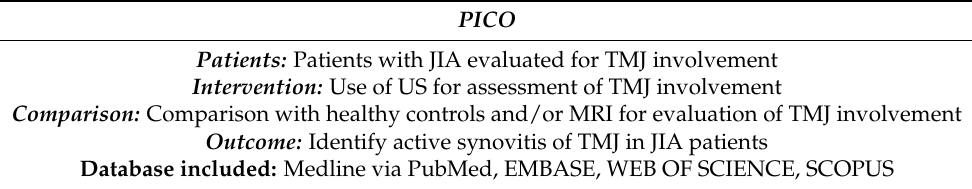
Table 1. The PICO table (population, intervention, comparison, and outcome). PICO Patients: Patients with JIA evaluated for TMJ involvement Intervention: Use of US for assessment of TMJ involvement Comparison: Comparison with healthy controls and/or MRI for evaluation of TMJ involvement Outcome: Identify active synovitis of TMJ in JIA patients Database included: Medline via PubMed, EMBASE, WEB OF SCIENCE,